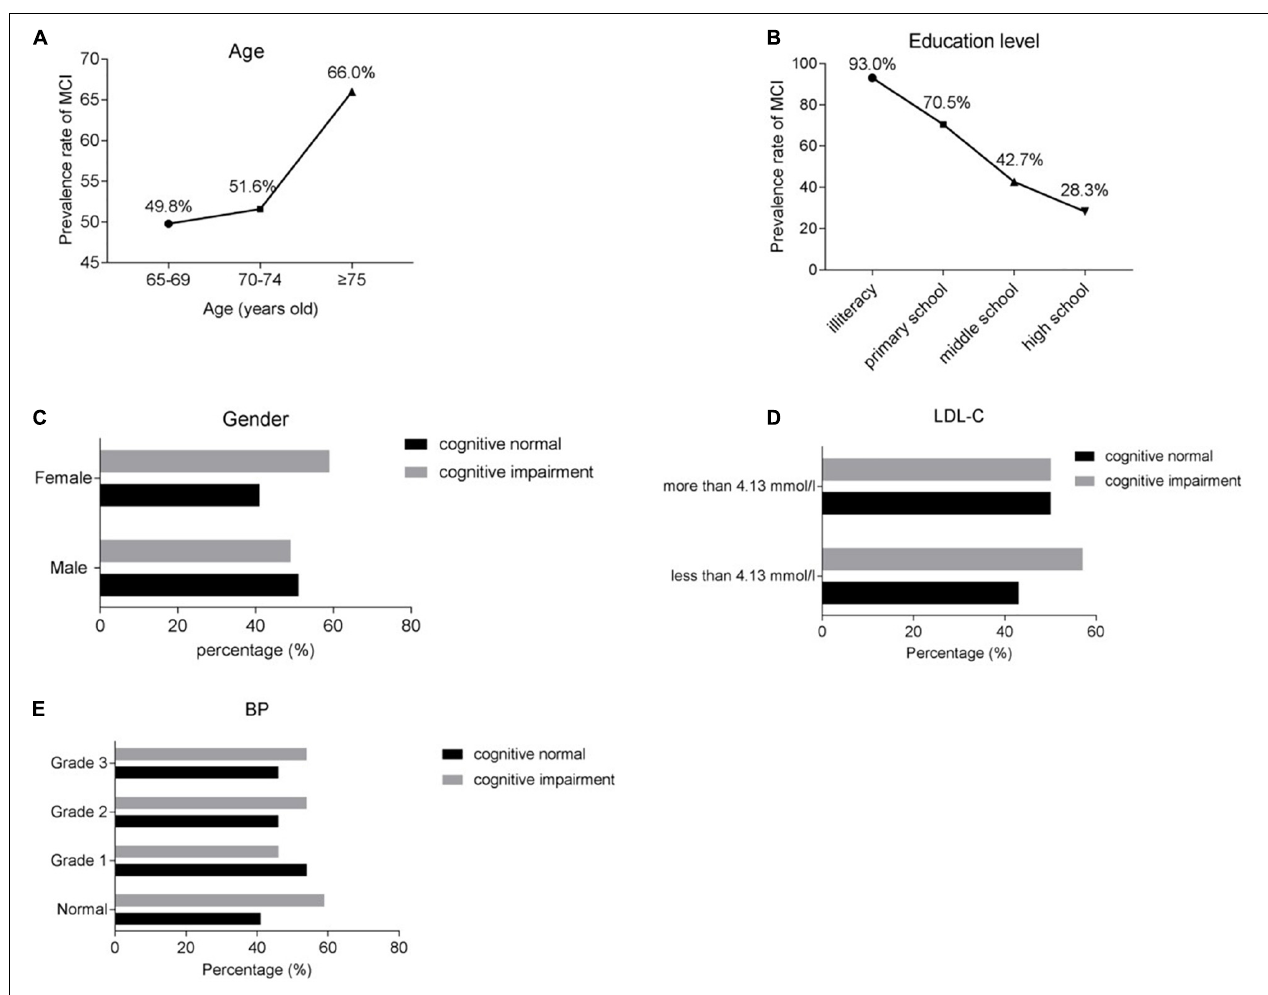
FIGURE 2 | The prevalence rate of cognitive impairment in various risk factors. (A) The prevalence rate of cognitive impairment in different ages. (B) The prevalence rate of cognitive impairment in different education level. (C) The prevalence rate of cognitive normal or impairment in gender level. (D) The prevalence rate of cognitive normal or impairment in different level of LDL-C level. (E) The prevalence rate of cognitive normal or impairment in different level of BP level. BP, blood pressure. LDL-C, low-density lipoprotein